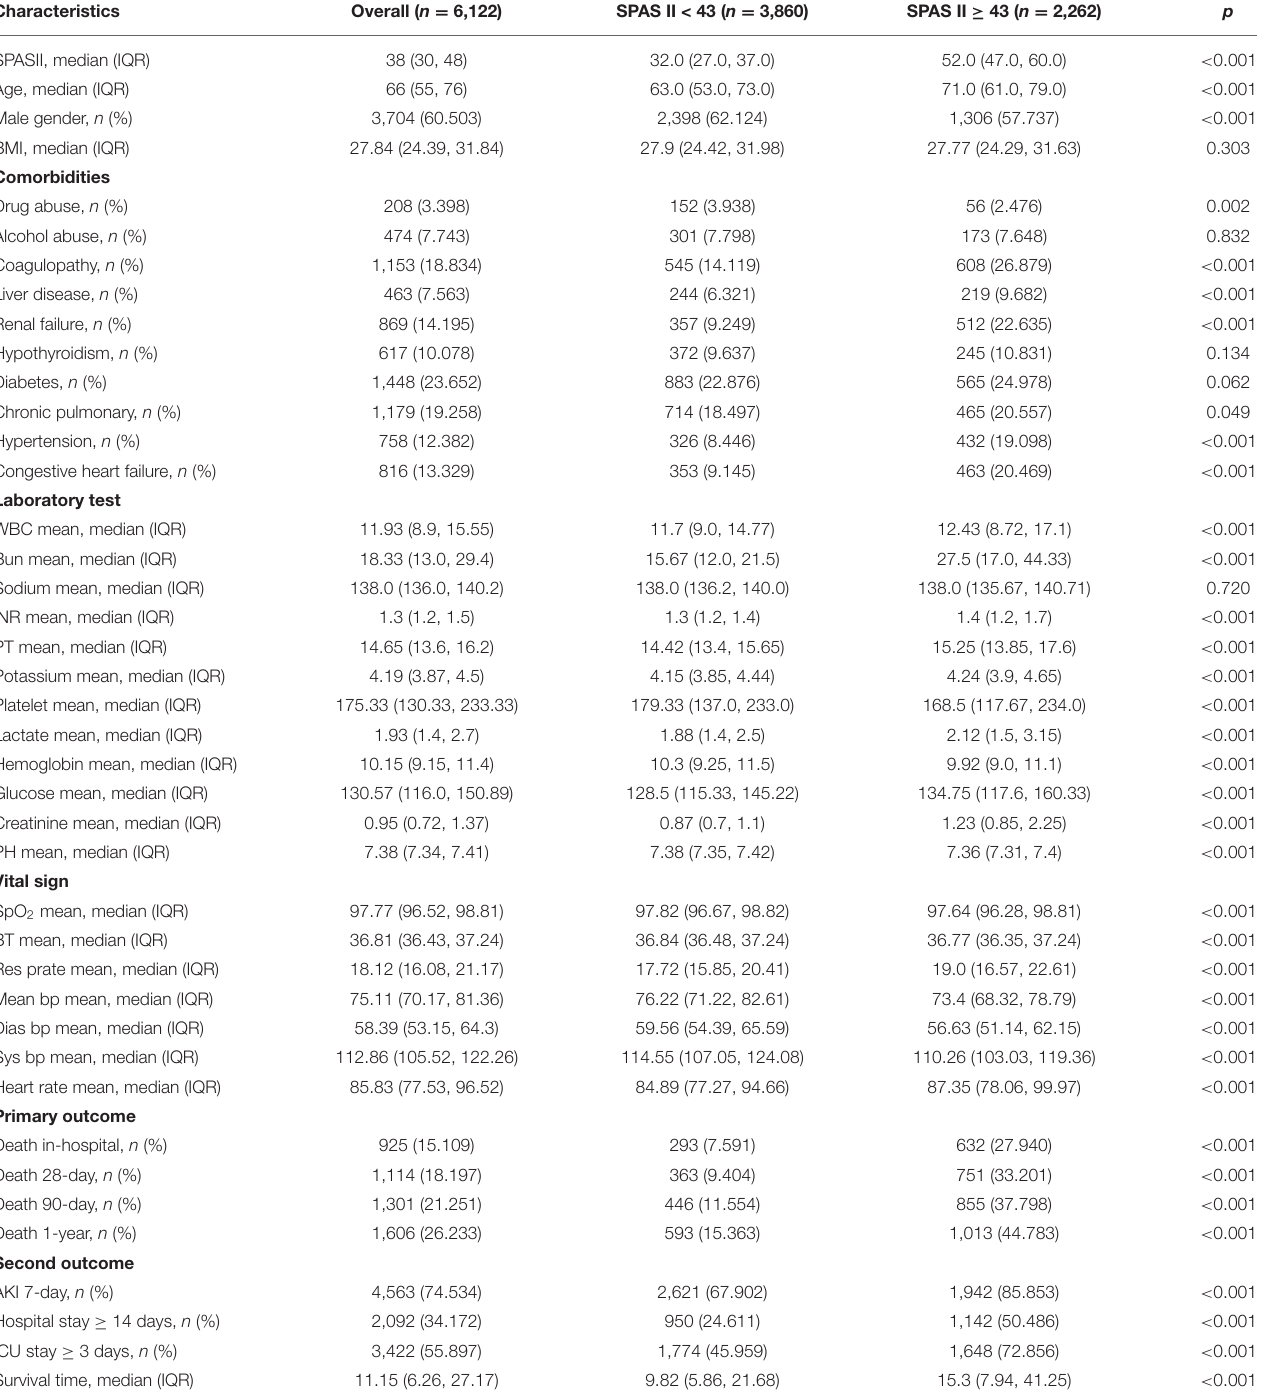
TABLE 4 | Basic characteristics of SAPS II scoring system.